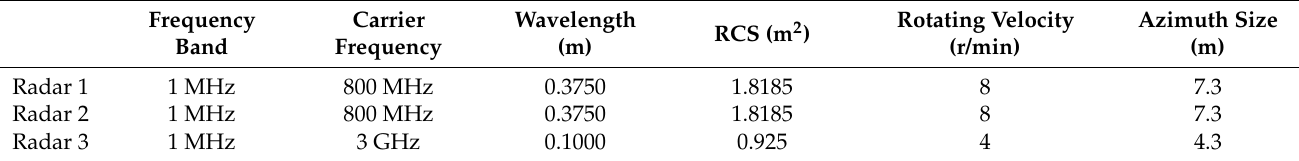
Table 6. Jamming performance evaluation results of ground ‐ based radar network (three radars).